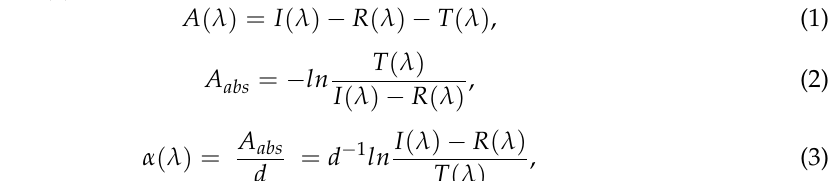
Figure 4. ( a ) G-peak position and I D /I G ratio, and ( b ) G-peak width and intensity in the RF-PECVD DLC thin films with various film thicknesses: 20, 40, 60, and 80 nm.